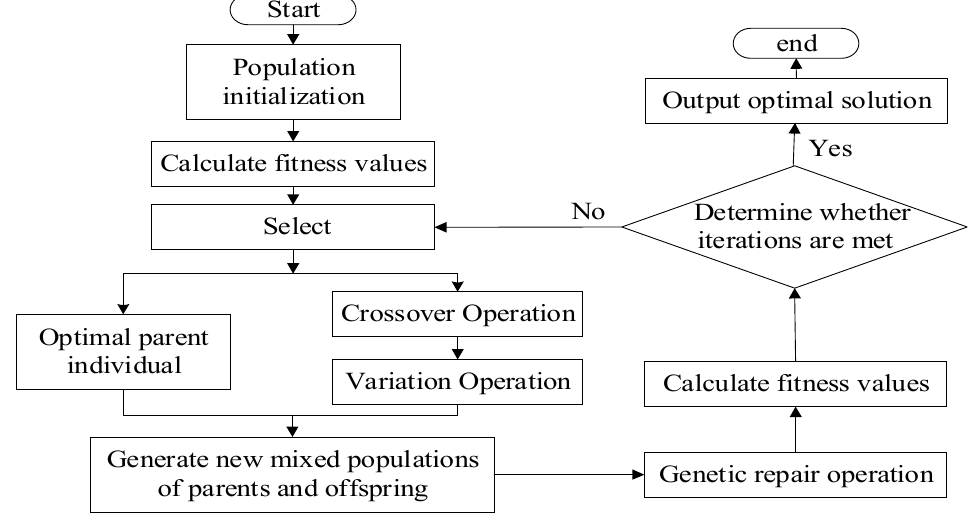
Figure 5. IGA flowchart.